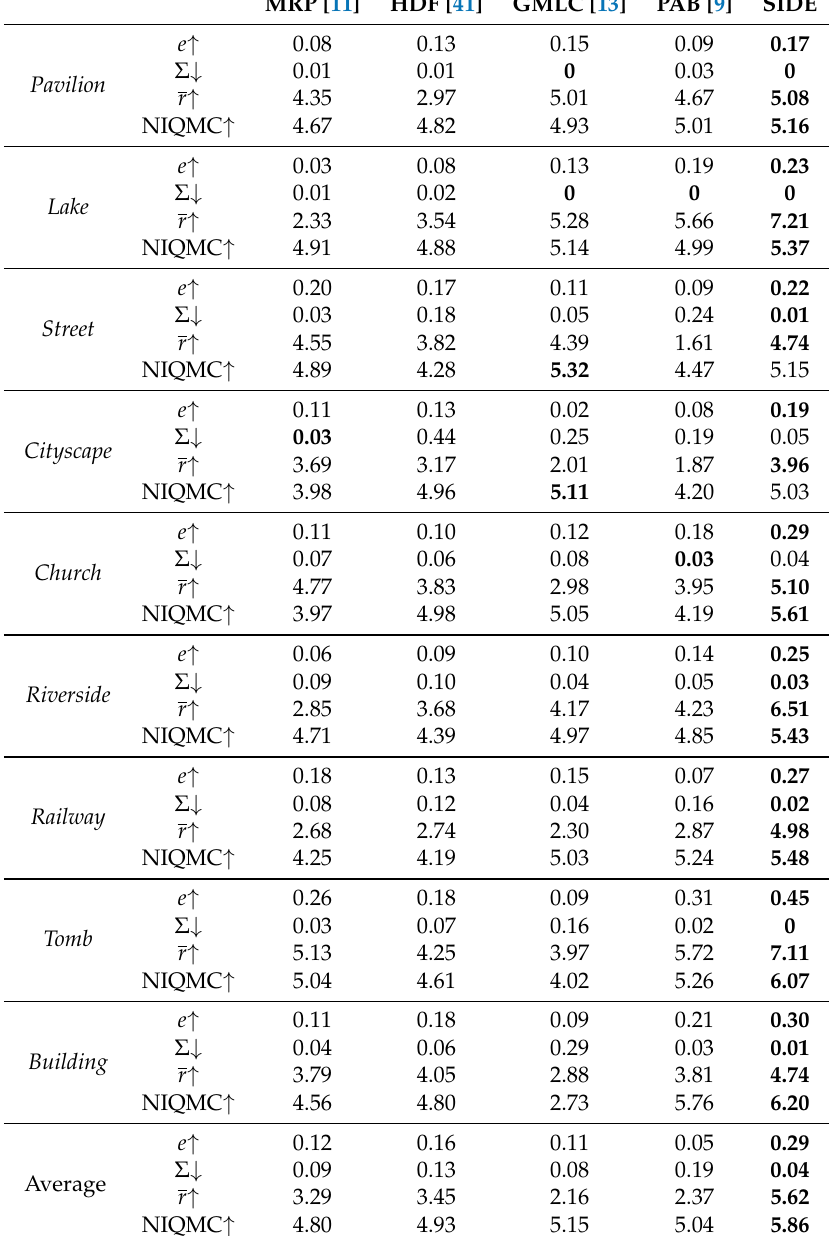
Table 1. Quantitative Comparison on Real-world Benchmark Dataset. The bold indicates the best scores of the quantitative